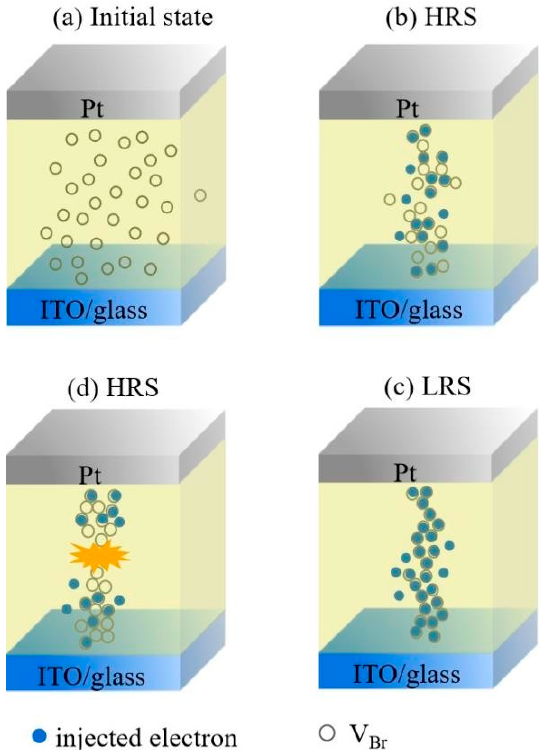
Figure 6. Schematic illustration of the conductive mechanism for the operation of the Pt/CABB/ITO/glass device. ( a ) Initially, the device is in the HRS due to the random distribution of V Brs . ( b ) V Brs captures injected electrons and moves toward ITO under a positive bias. ( c ) The conductive filament of V Brs forms in the CABB layer and switches the device to LRS. ( d ) The filament is broken and the device switches into HRS.